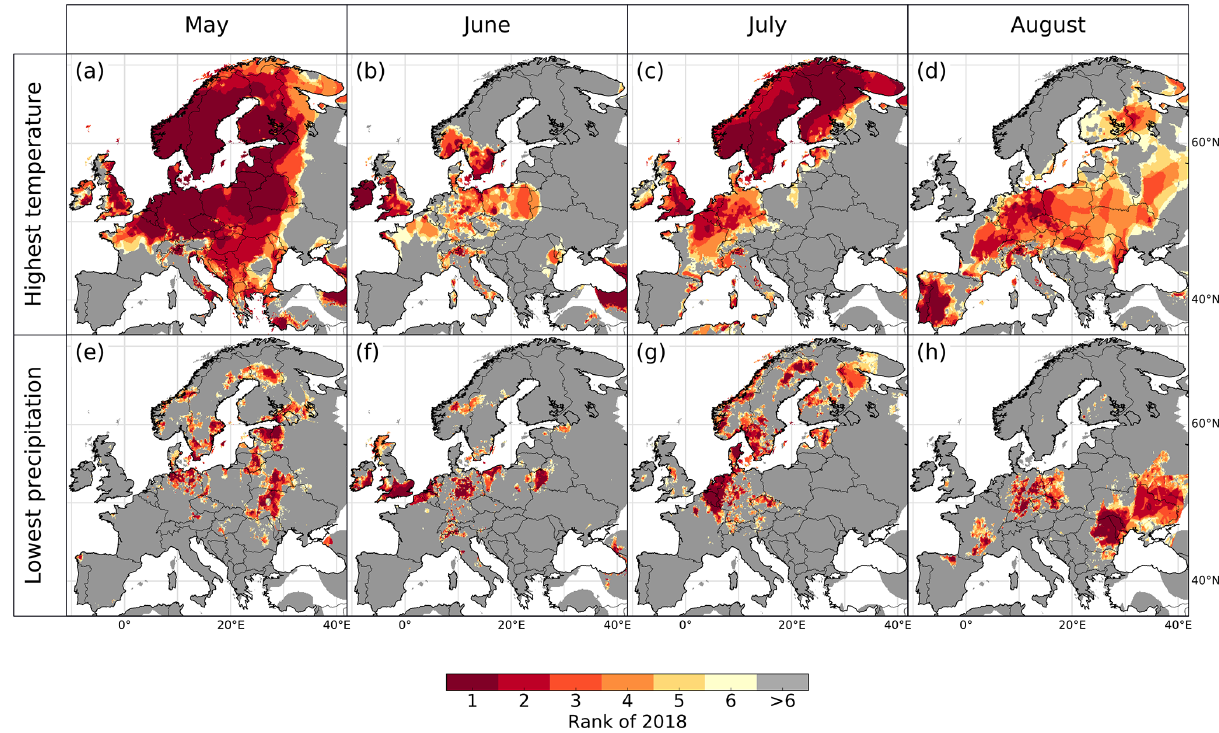
Figure 5. Top-six ranking of 2018 highest temperature (monthly mean of daily maximum temperature) for (a) May, (b) June, (c) July, and (d) August and top-six ranking of 2018 lowest precipitation for (e) May, (f) June, (g) July and (h) August. Analysed period is 1959–2018. A rank of 1 signifies that 2018 had the warmest (in the case of temperature) or driest (in the case of precipitation) month since 1959, a rank of 2 signifies that 2018 had the second most extreme value in that month,